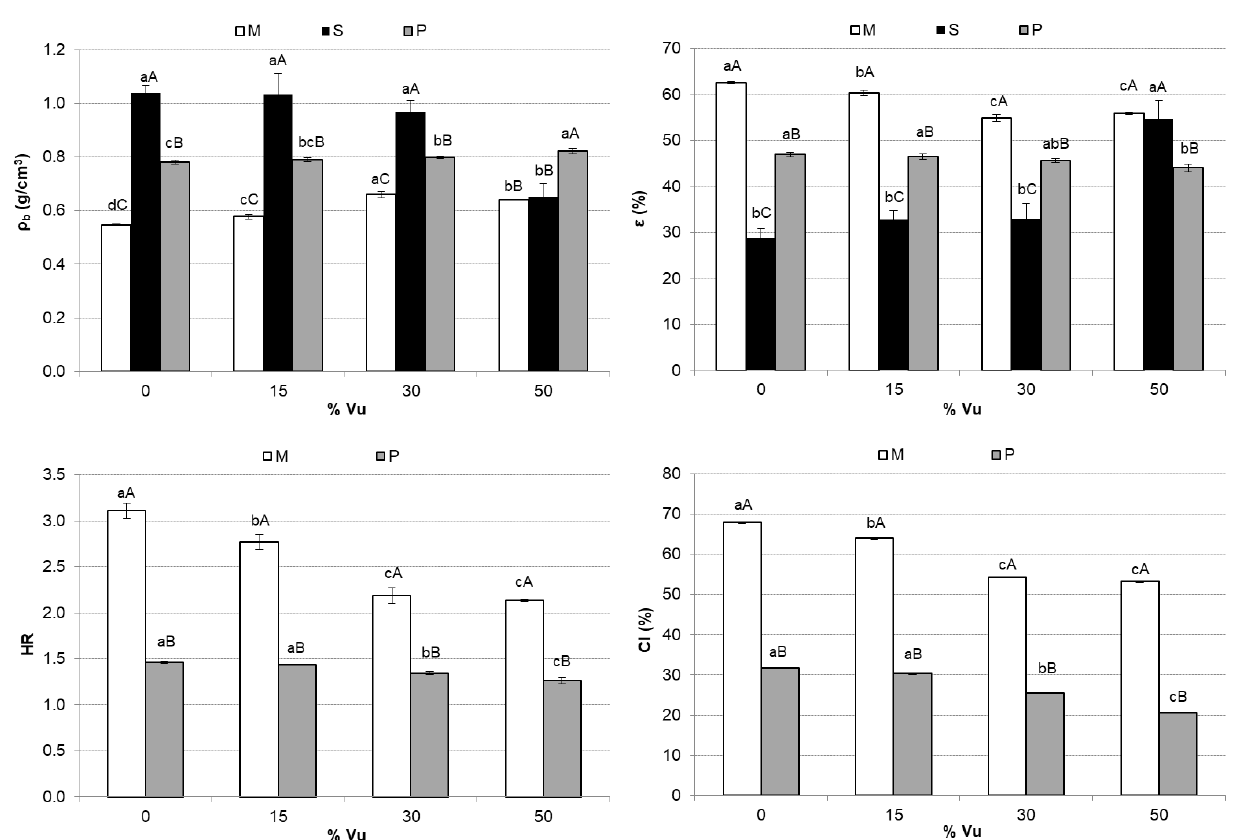
Figure 4. Mean values and standard deviation of the bulk density ( ρ b ), porosity ( ε ), Hausner ratio (HR), and Carr index (CI) of the mixtures (M), the section of the pellet (S), and powder (P) in each case. For each parameter, the same small letter indicates homogeneous groups established by ANOVA ( p < 0.05) by comparing the Vu percentages (0, 15, 30, and 50) in M, S, or P. For each Vu percentage (0, 15, 30, and 50) and parameter, the same capital letter indicates homogeneous groups established by ANOVA ( p < 0.05) by comparing M, S, and P.